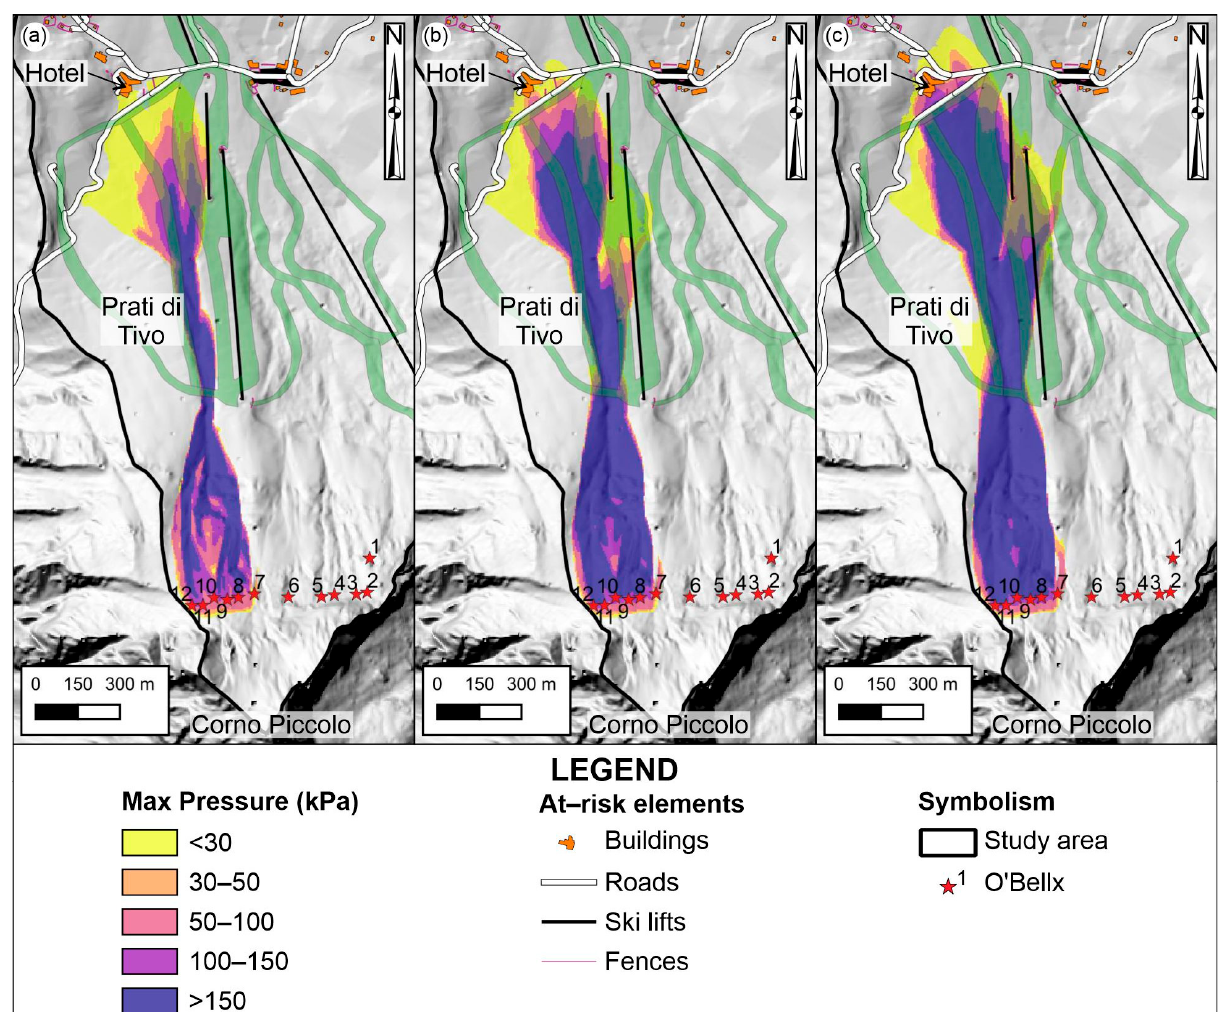
Figure 17. Results of the avalanche dynamics simulation under different transmitted pressures and heights of snow cover: ( a ) Hc = 0.5 m, ( b ) Hc = 1.0 m, and ( c ) Hc = 1.5 m.